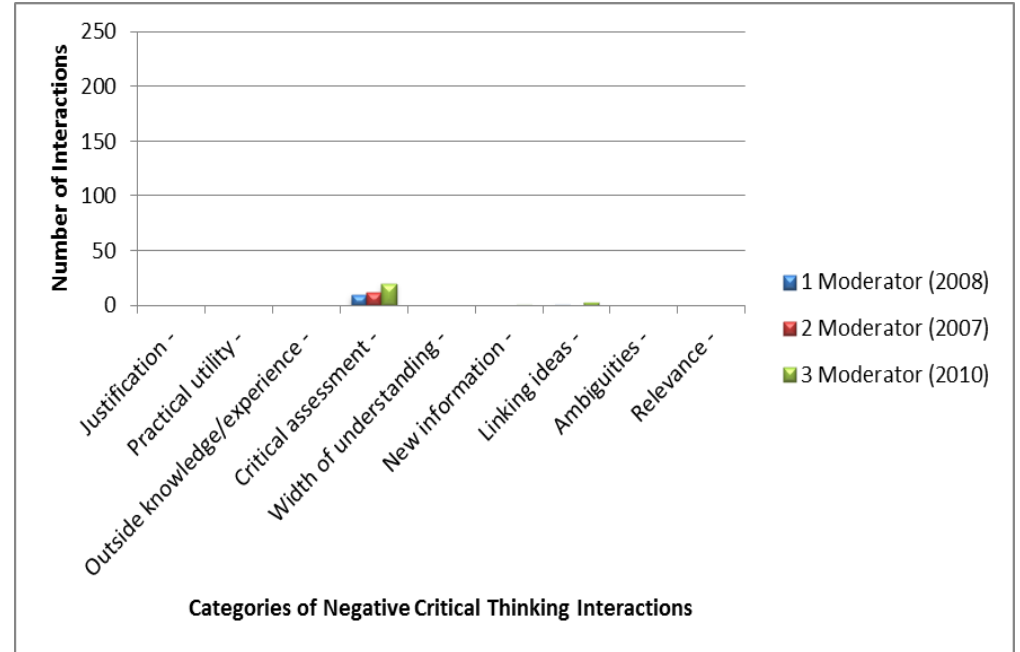
Figure 6. Number ( y axis) and negative critical thinking interactions ( x axis) of 1, 2, and 3 SM